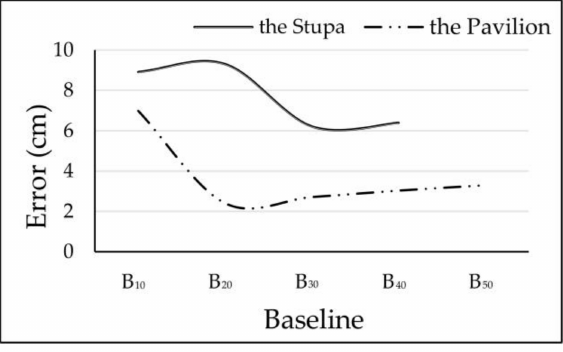
Figure 14. Median absolute errors with variable baselines in the two